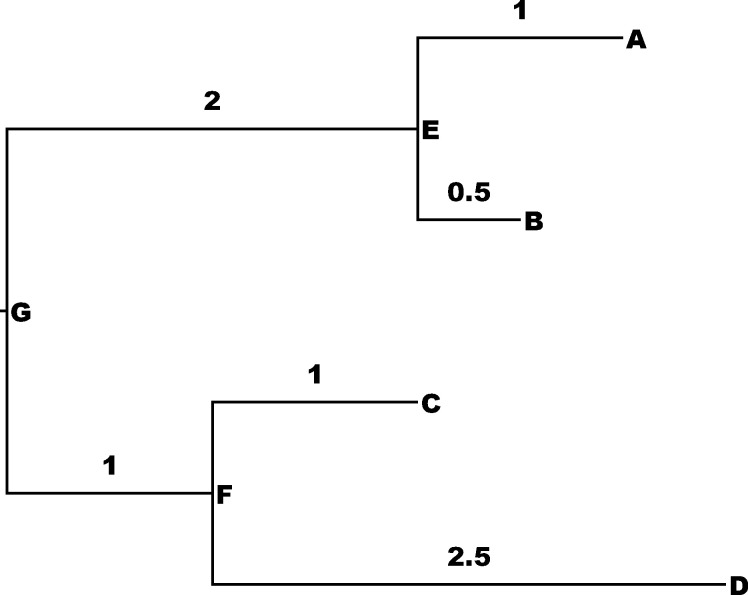
The “Simple” tree.